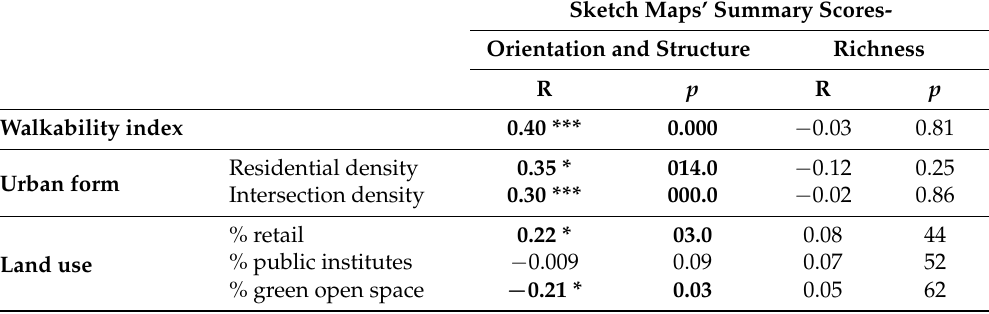
Table 4. Correlations between sketch maps’ summary scores and objective environmental measures en-route (Pearson coefficient, N =